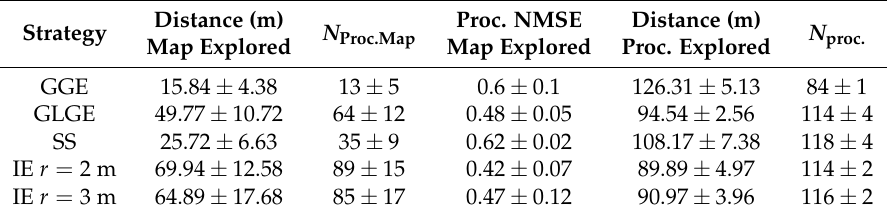
Table 6. Mean value and standard deviation over five runs for scenario S2: (i) mapping: Total travelled distance needed to explore the map with accompanied number of obtained process measurements N proc.,map and process NMSE; (ii) process exploration: Total exploration distance needed to explore the process and number of collected measurements ( N proc. ) required to achieve NMSE of 0.21 with respect to the ground